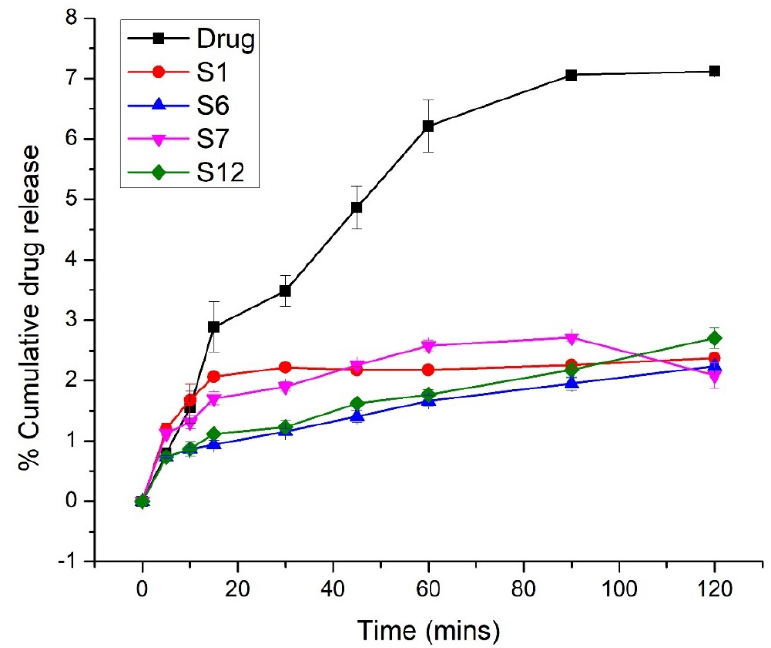
Figure 6. Dissolution profile at pH 1.2 (0.1 N HCl).